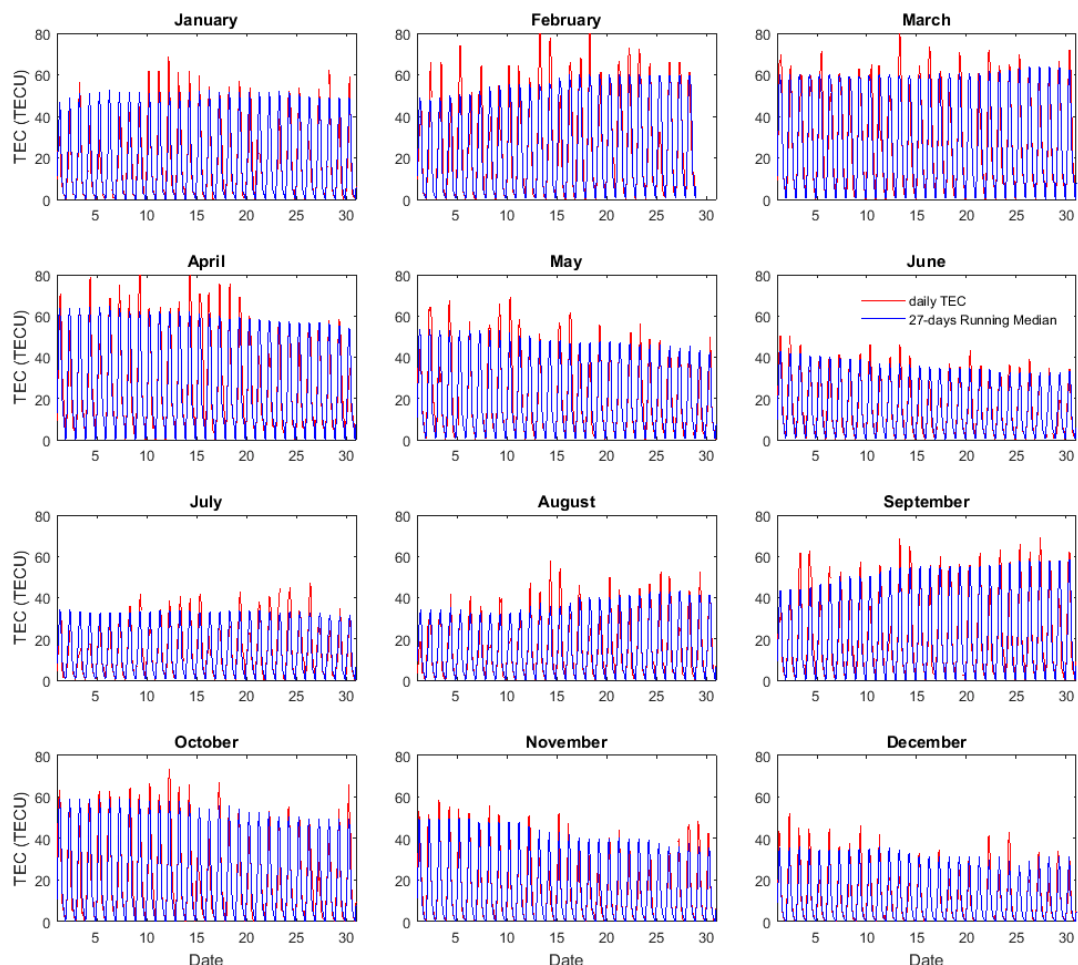
Figure 3. Daily TEC variation observed at HKWS during January–December 2016. The daily TEC variation and 27-day running median are shown in red and blue lines, respectively.